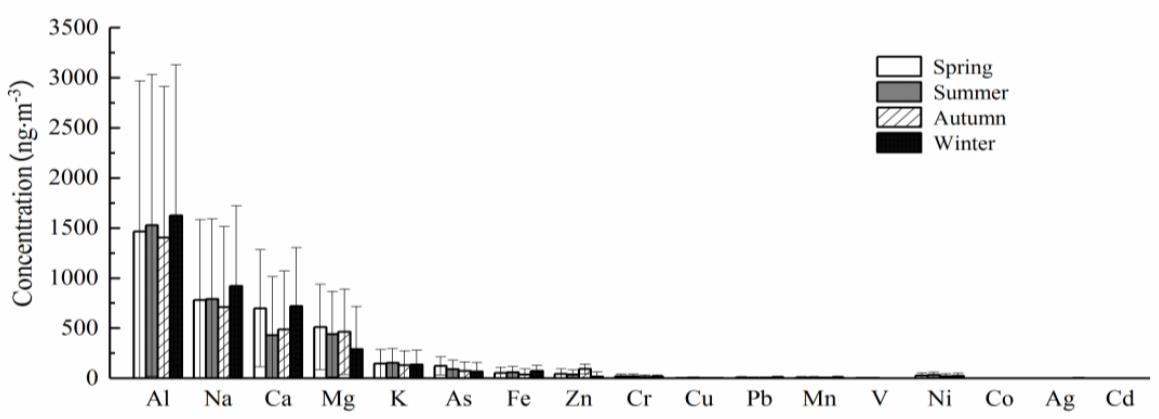
Figure 3. Metal element concentrations in PM 2.5 samples collected from Xinxiang city. Al, aluminum; Na, sodium; Ca, calcium; Mg, magnesium; K, potassium; As, arsenic; Fe, iron; Zn, zinc; Cr, chromium; Cu, copper; Pb, lead; Mn, manganese; V, vanadium; Ni, nickel; Co, cobalt; Ag, silver; Cd, cadmium